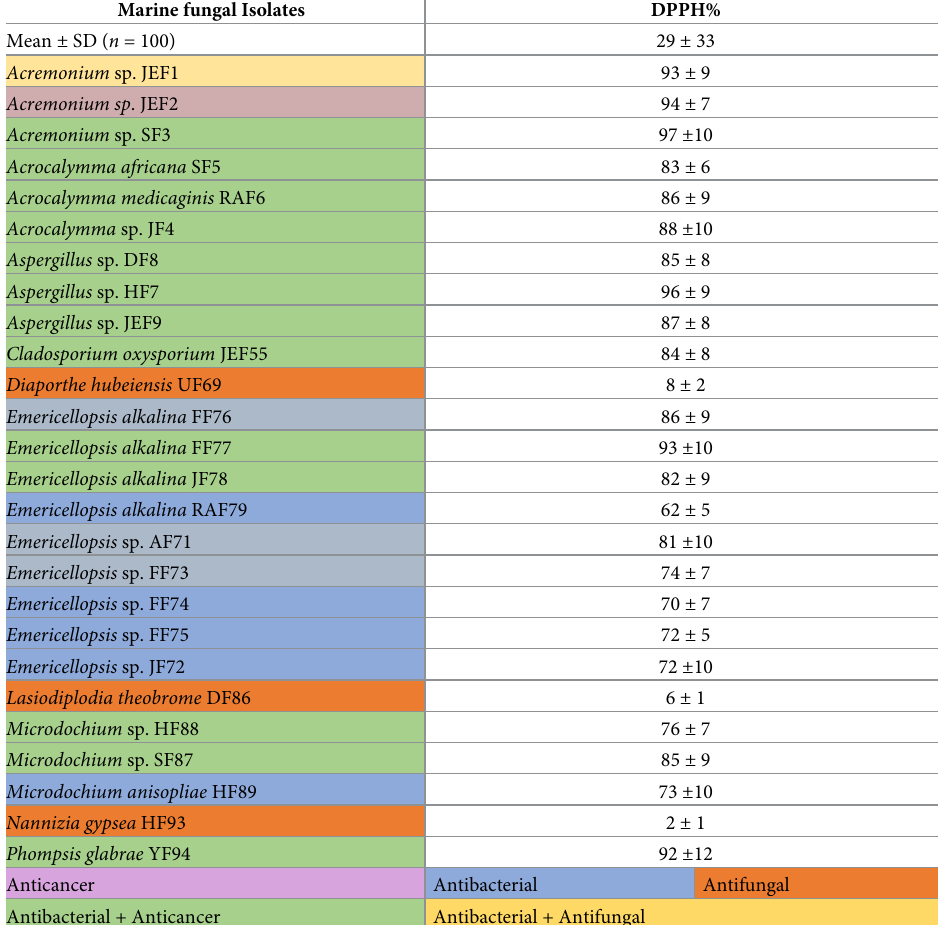
Table 3. Antioxidant activity (DPPH scavenging activity %) of marine fungal isolates (mean ± SD, n = 3) with high antibacterial, antifungal, or anticancer activity (referred as colors) in comparison with the mean of all marine fungal